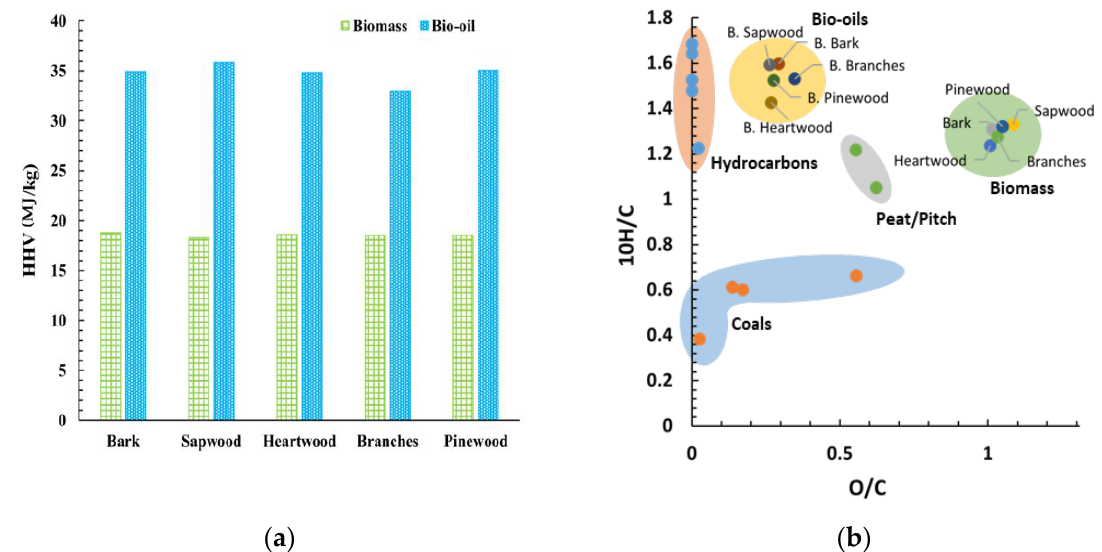
Figure 5. ( a ) HHV comparison of biomass and bio-oil; ( b ) van Krevelen diagram of the different